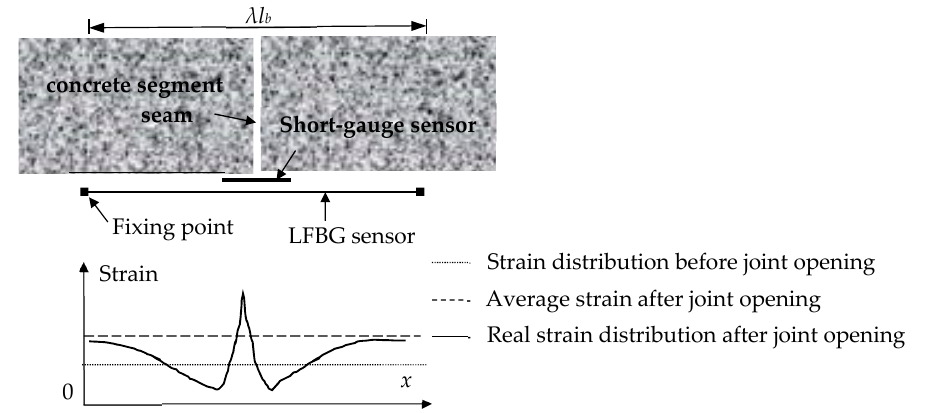
Figure 4. The structural design of the packaged LFBG sensor [40].